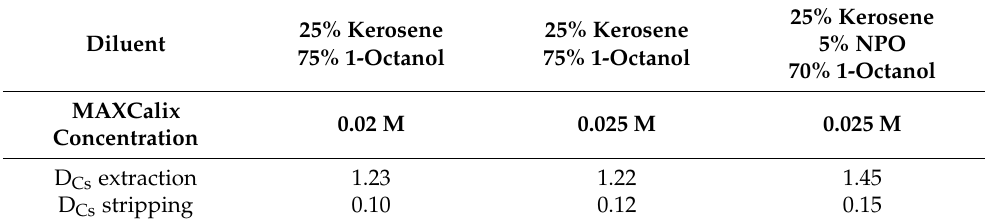
Table 4. Cs + extraction and stripping distribution ratios for 3 different organic phases. Aqueous phase (extraction), 4 M MgCl 2 , 1 M KCl, 0.3 M NaCl, 0.2 M MgSO 4 , 1 mM CsCl + 0.001 M HCl.